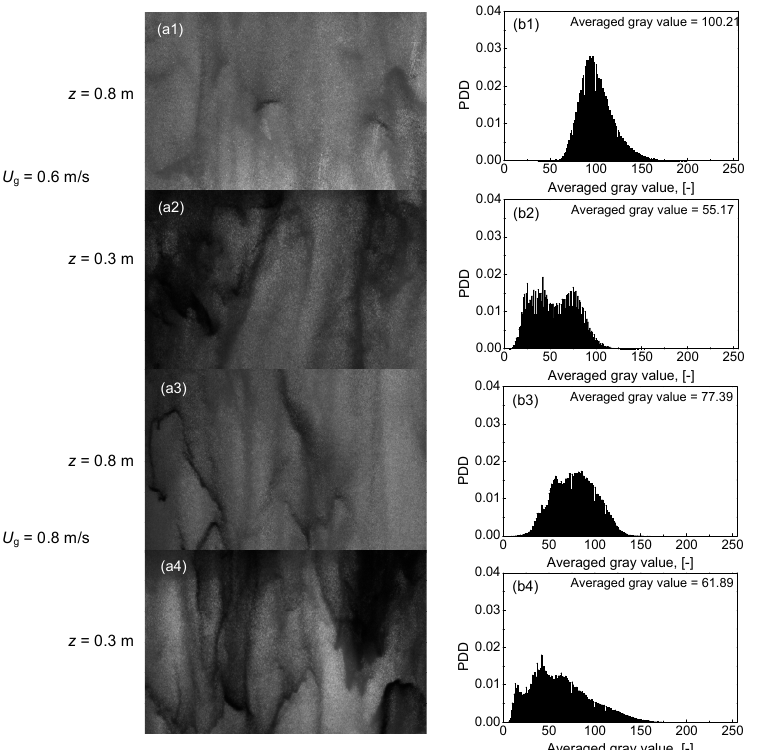
Figure 13. Gas-solids flow images in the gas-solids turbulent fluidized bed of Group A particles with an initial bed height of 0.05 m. ( a ) Original iamge. ( b ) Grayscale histogram. The solids holdup distribution based on image testing at different operation conditions is given in Figure 14. It is shown that solids holdup decreases from the bottom to the top of the bed height at a fixed superficial gas velocity and initial bed height. At a